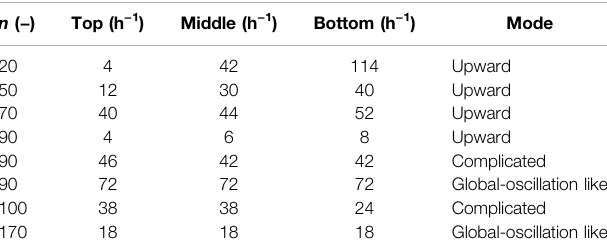
TABLE 2 | Frequencies of chemical oscillations, f at three different positions of the tube for n values of 20 – 170 ( Figure 2